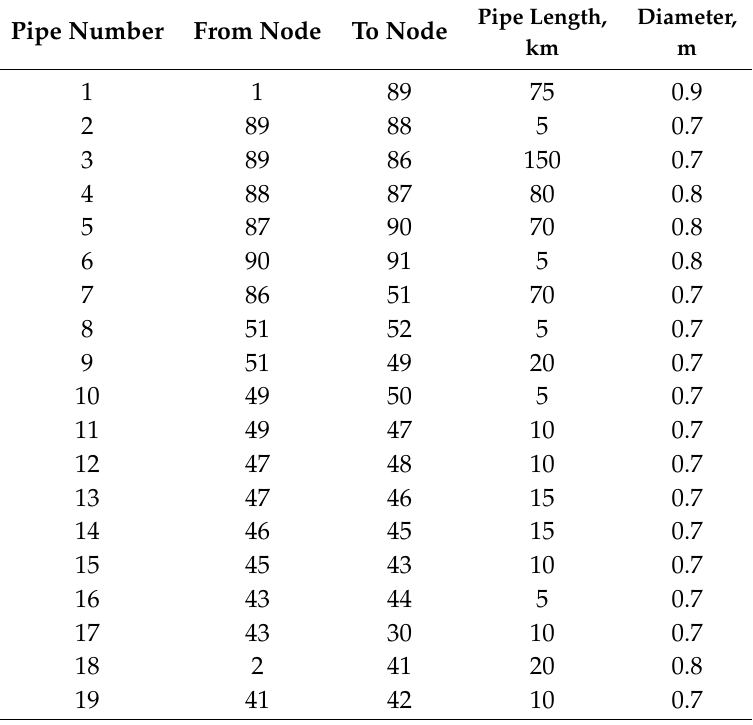
Table A1. Parameters of the gas flow equation in the bigger network with 109 nodes and 112